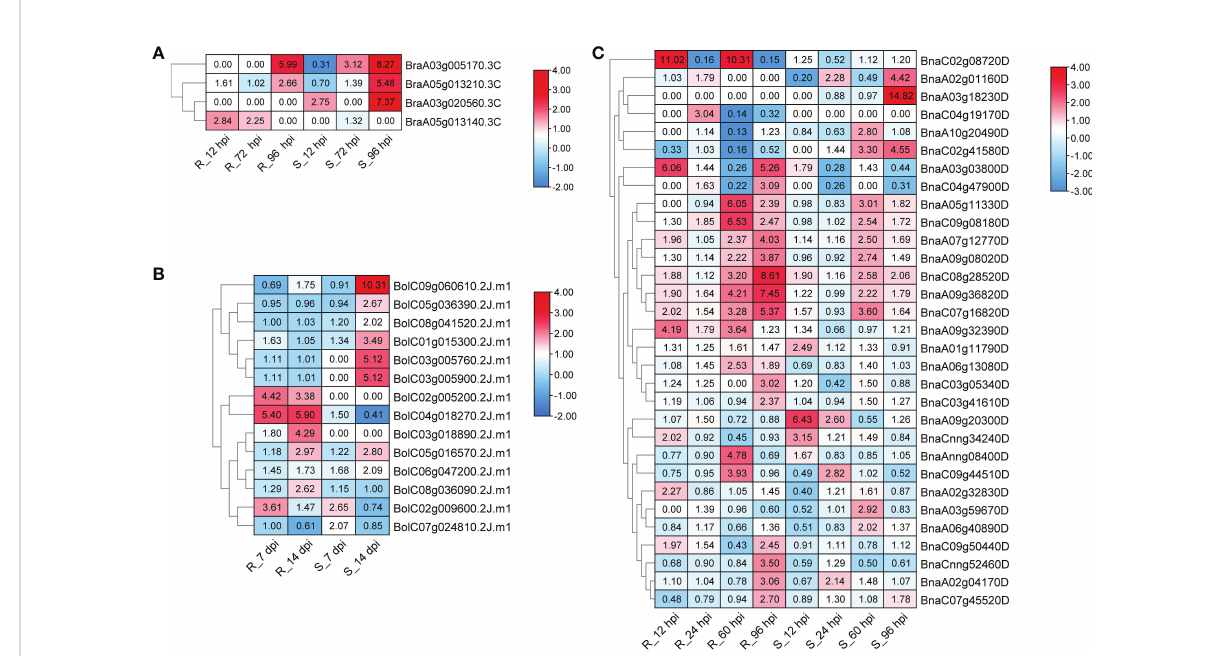
FIGURE 6 Heat maps of upregulated BraCPKs (A) , BolCPKs (B) , and BnaCPKs (C) elicited by P. brassicae . R and S, resistant and susceptible genotype, respectively. hpi: hours post-inoculation, dpi: days post-inoculation. The red color indicates up-regulated, and numbers in boxes indicate fold change. The legends show log 2 fold-change. TPM value was used for heat map